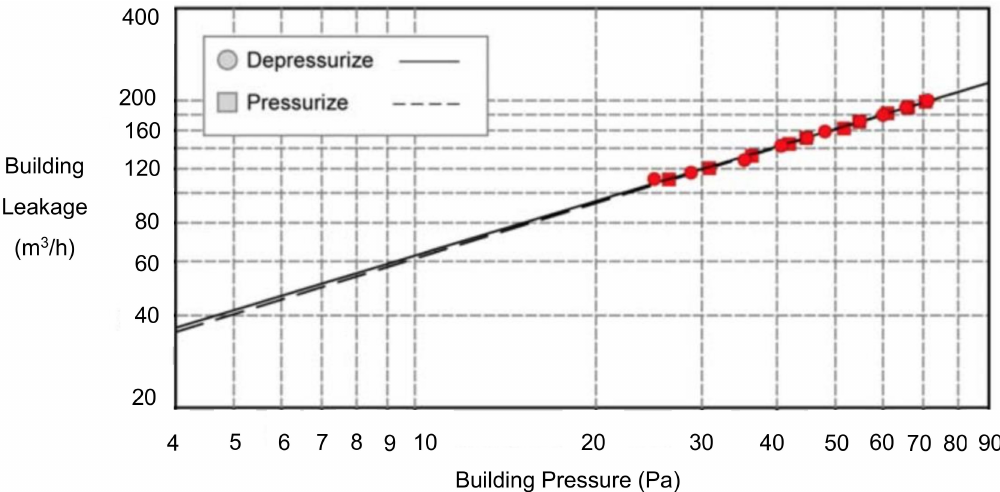
Figure 21. Dwelling envelope airtightness test after refurbishment.